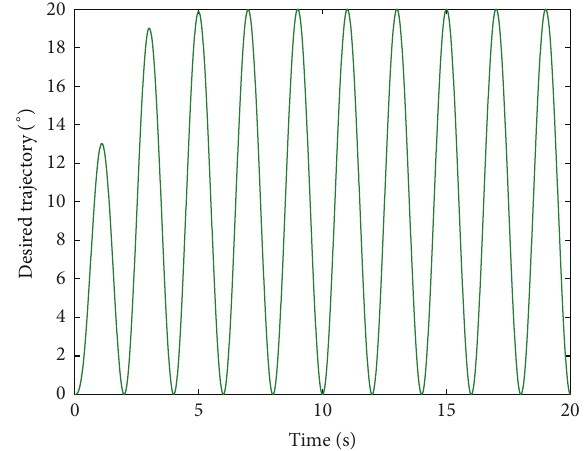
Figure 4: The desired trajectory (normal case).